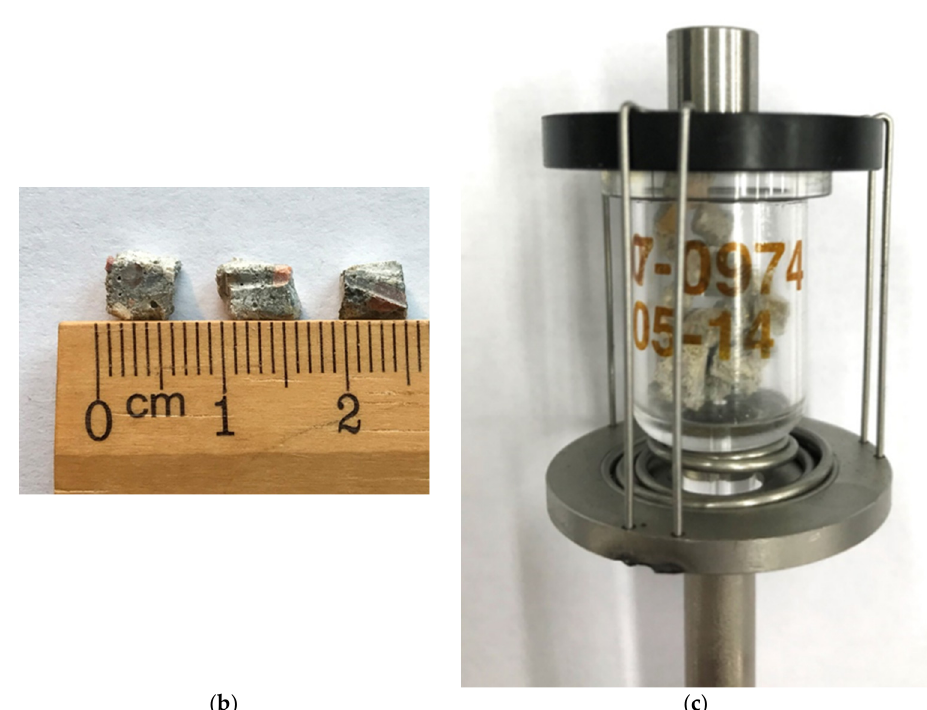
Figure 4. ( a ) Size of the analyzed cement paste chipped off concrete; ( b ) sample of the analyzed cement paste; ( c ) the analyzed specimen in the penetrometer before measurement.